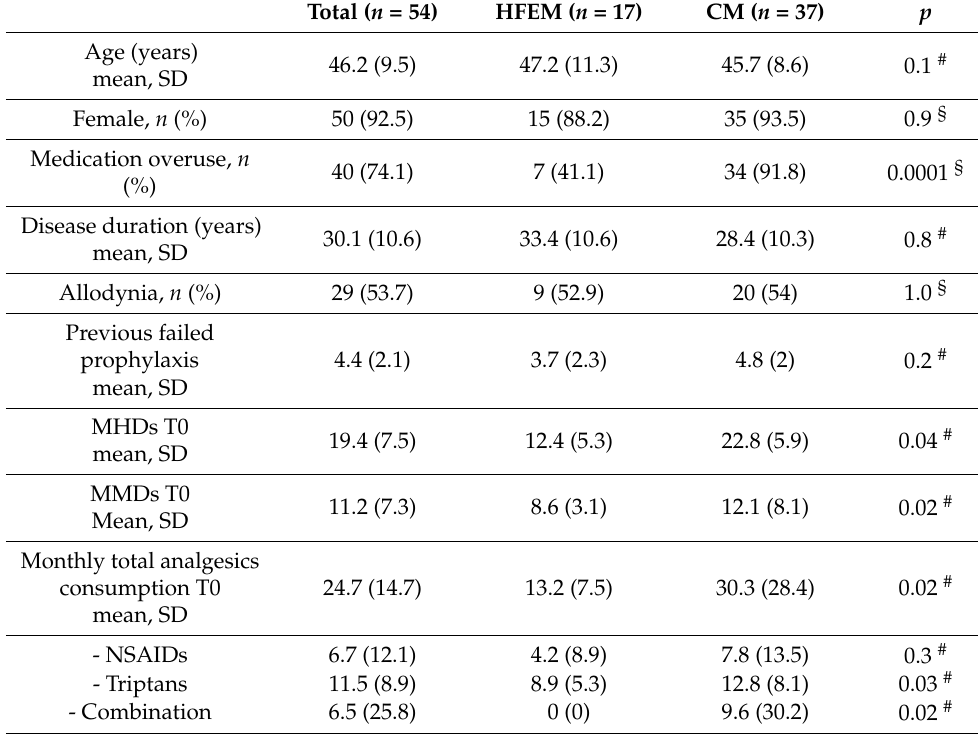
Table 1. Baseline clinical and demographical